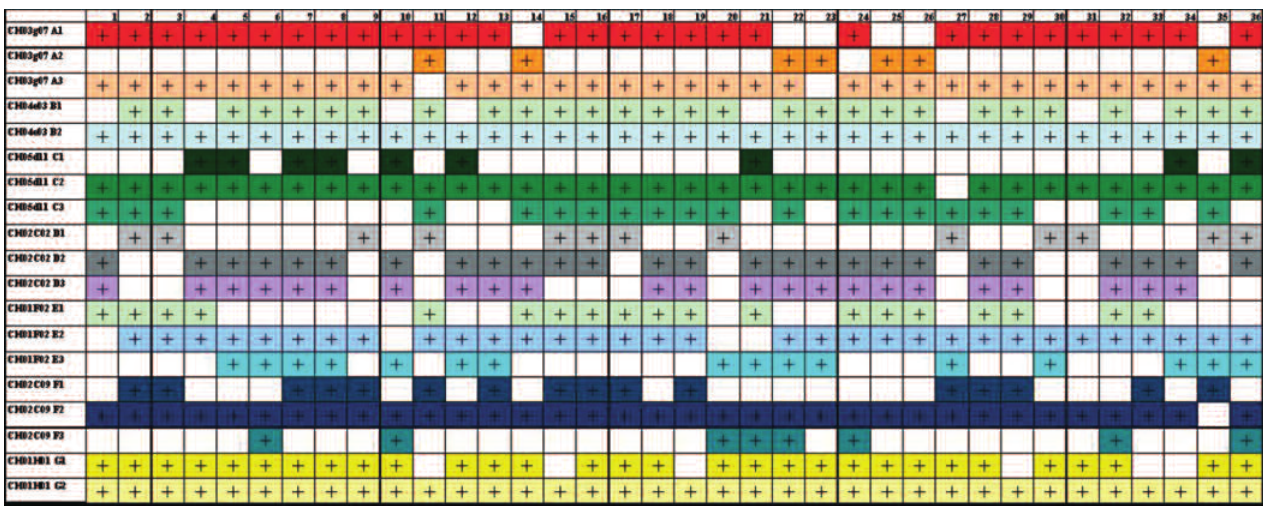
Figure 1: Frequency of alleles observed in 36 quince cultivars at each SSR